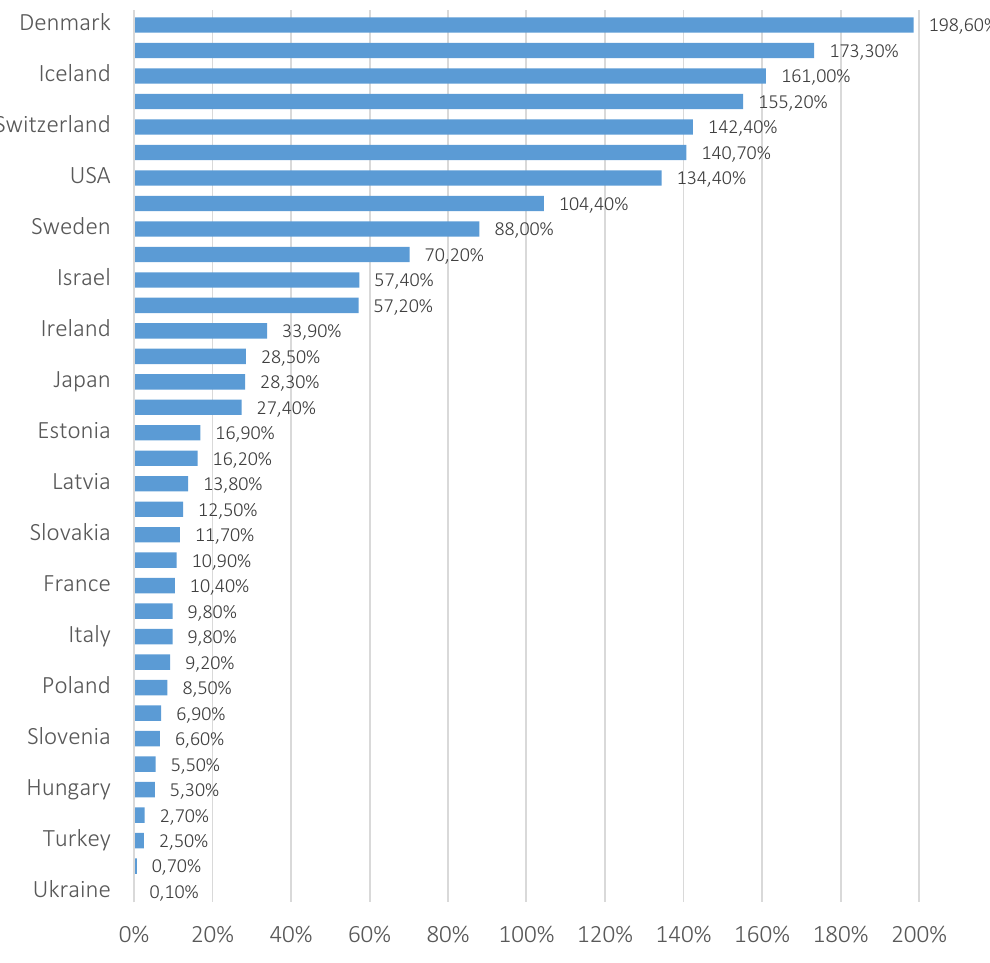
Figure 3. The ratio of the assets of accumulative and private pension funds and GDP in selected OECD countries in 2018,